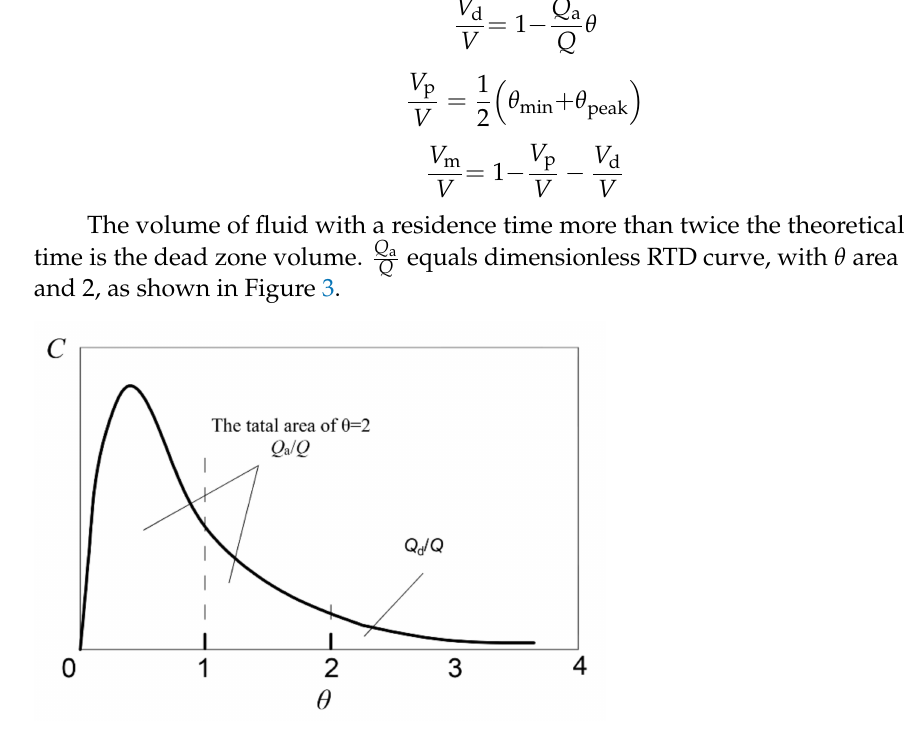
Figure 3. Common single-strand tundish RTD curve